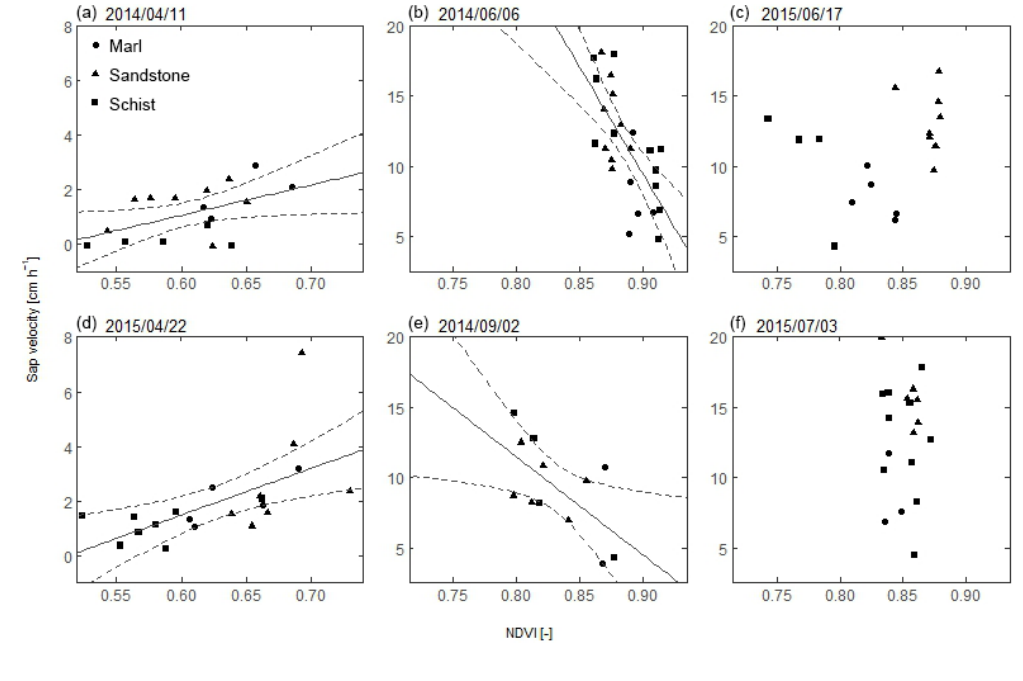
Figure 7. Relationship between sap velocity and NDVI for 6 days. Each dot represents one sensor cluster in the sandstone, schist, and marl area. The dashed line represents the 95% confidence interval. (a, d) April 2014 and 2015, during the period of green-up. At the (b) start and (e) end of the growing season in 2014. (c, f) At the beginning of the dry summer of